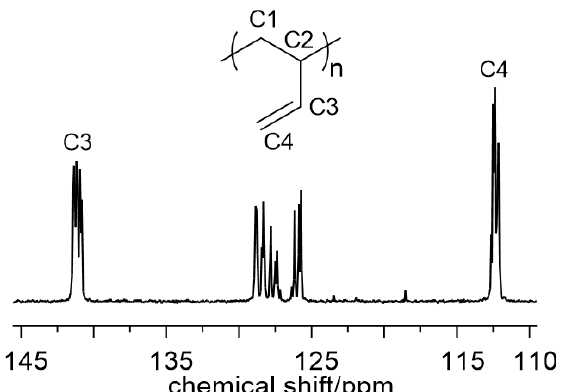
Figure 2. The 13 C NMR spectrum (olefinic region) of 1,2 syndiotactic poly(1,3-butadiene) obtained with Cu(bipy)Cl 2 /MAO (Table 1, entry 2).